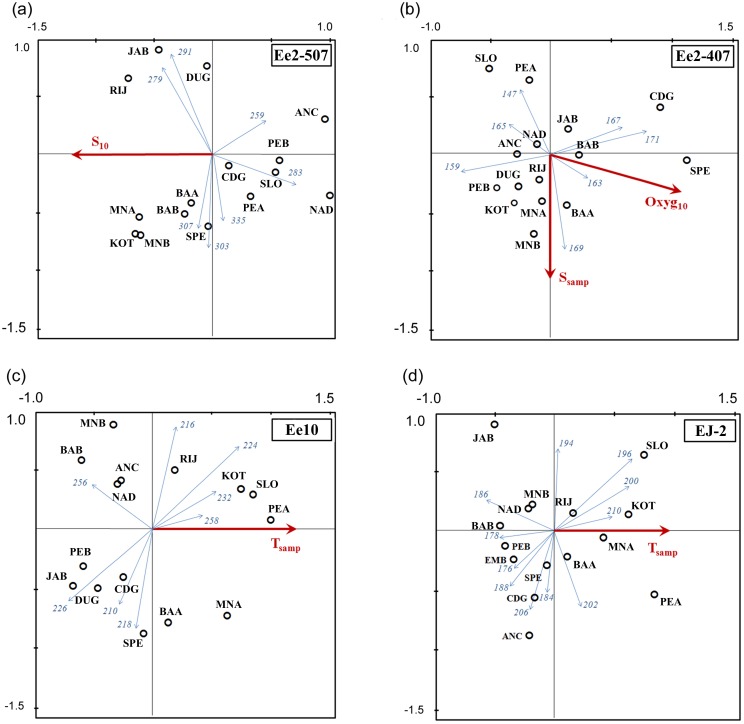
Redundancy Discriminant Analysis (RDA) triplots.Triplots show the distribution of samples (circles) relative to major significant environmental variables (dashed arrows) and microsatellite allele frequencies (solid arrows) at four candidate outlier loci. Triplots show results for Ee2-507 (A), Ee2-407 (B), Ee10 (C) and EJ2 (D), respectively.